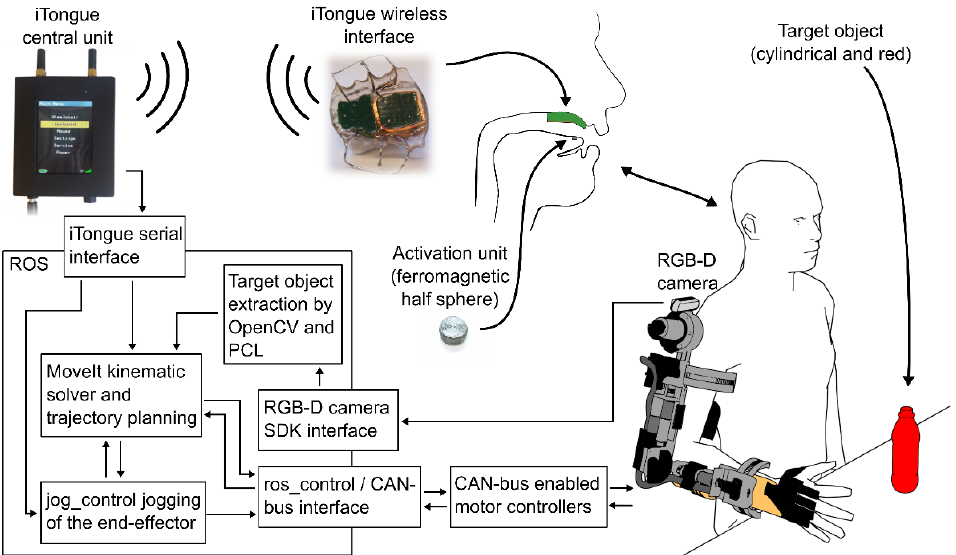
Figure 6. System overview. From the right bottom: The exoskeleton communicates via CAN-bus with a computer. From here all sensors of the exoskeleton are read and all motors are controlled. The RGB-D camera on the shoulder feeds its images through a computer vision pipeline resulting in a relative position and orientation of a target object (red bottle) enabling autonomous control. The user commands the exoskeleton through the adapted iTongue mouth unit. The wireless signals are received by the iTongue central unit, which in turn sends the received commands through a serial connection to a PC running the ROS ecosystem. Linear and square arrows indicate communication, double arrows indicate bidirectional communication. Note: the exoskeleton glove used in this study is not shown in this overview, but it is controlled through a USB serial interface.